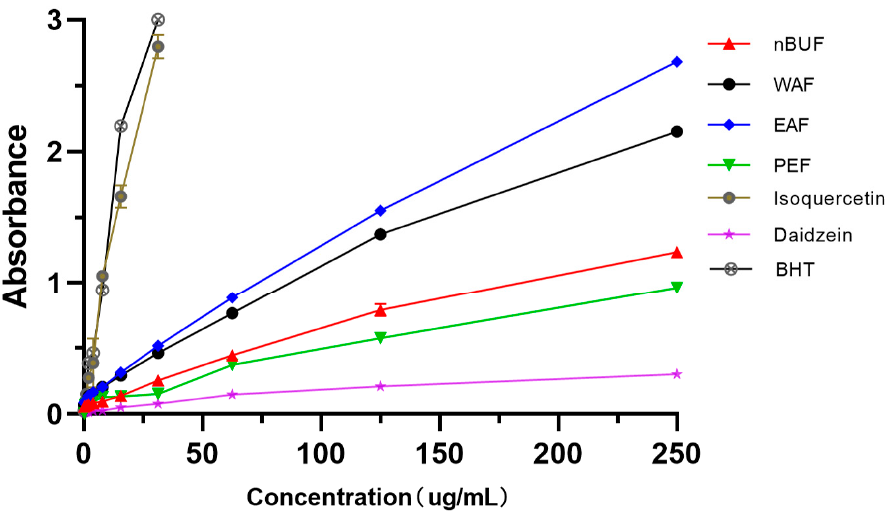
Figure 4. The iron ion reducing abilities of different preliminary purification fractions and stan- dard samples.